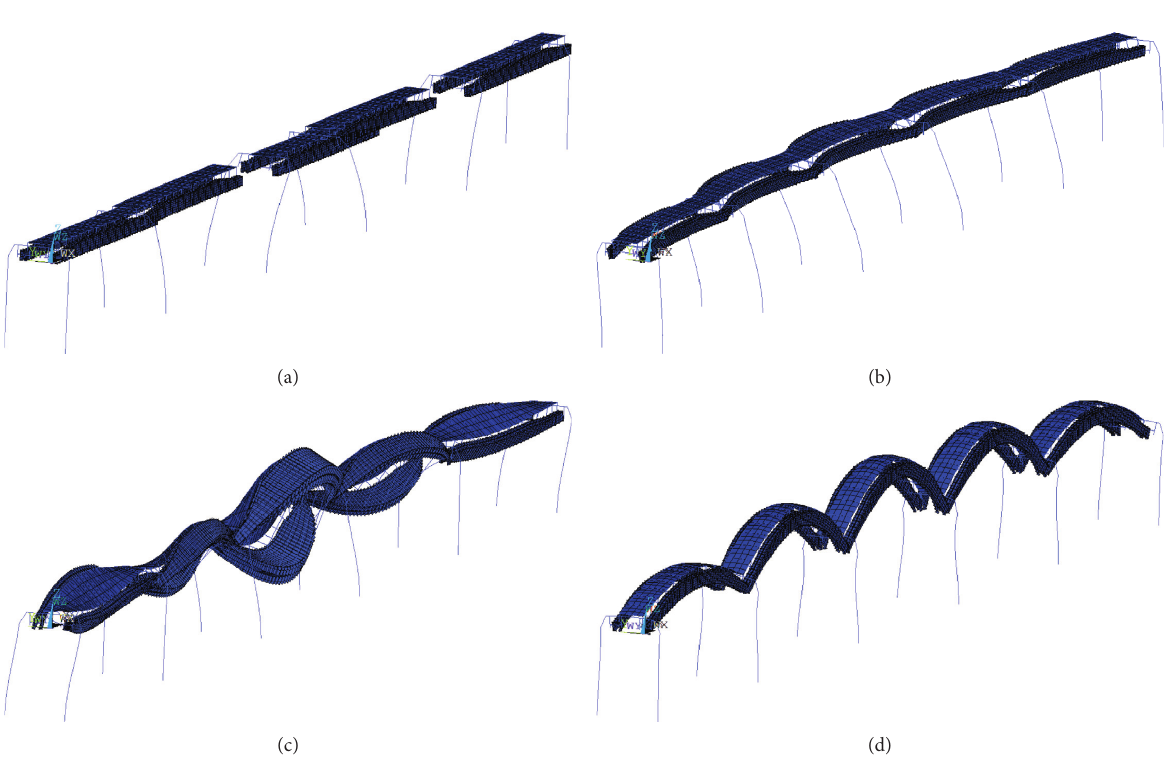
Figure 4: Typical mode shapes of the structure. (a) Longitudinal drift of pier. (b) Transverse bending of pier. (c) Torsion of track beam. (d) Vertical bending of track beam and footpath.